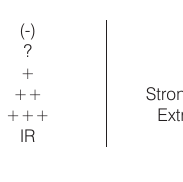
(-) Negative reaction